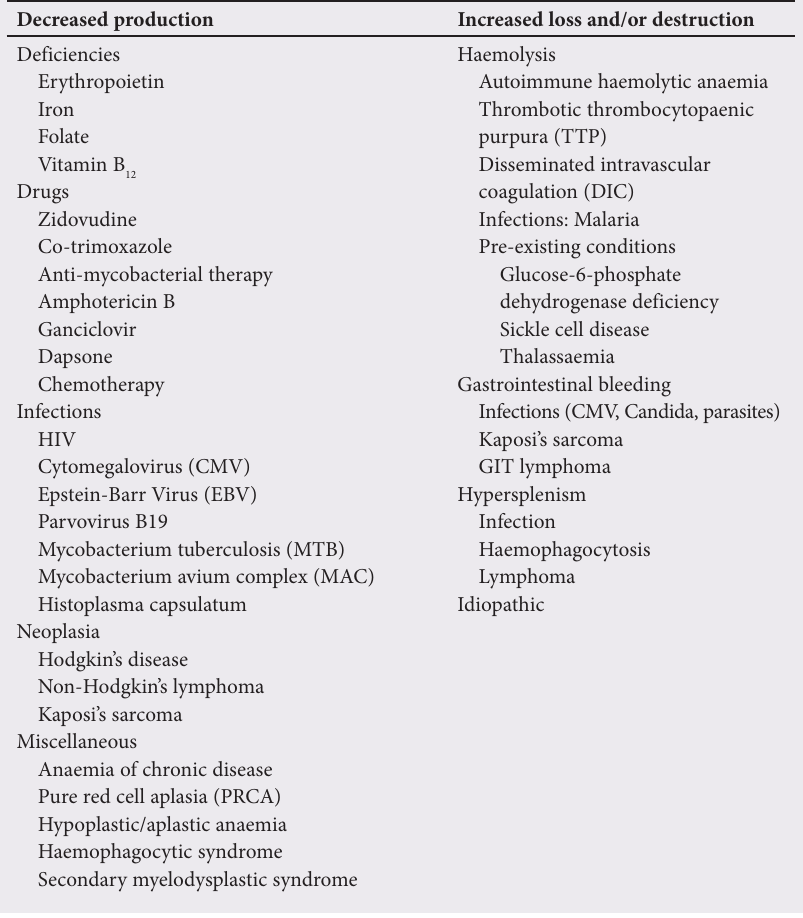
Table 1. Anaemia and HIV-infection Decreased